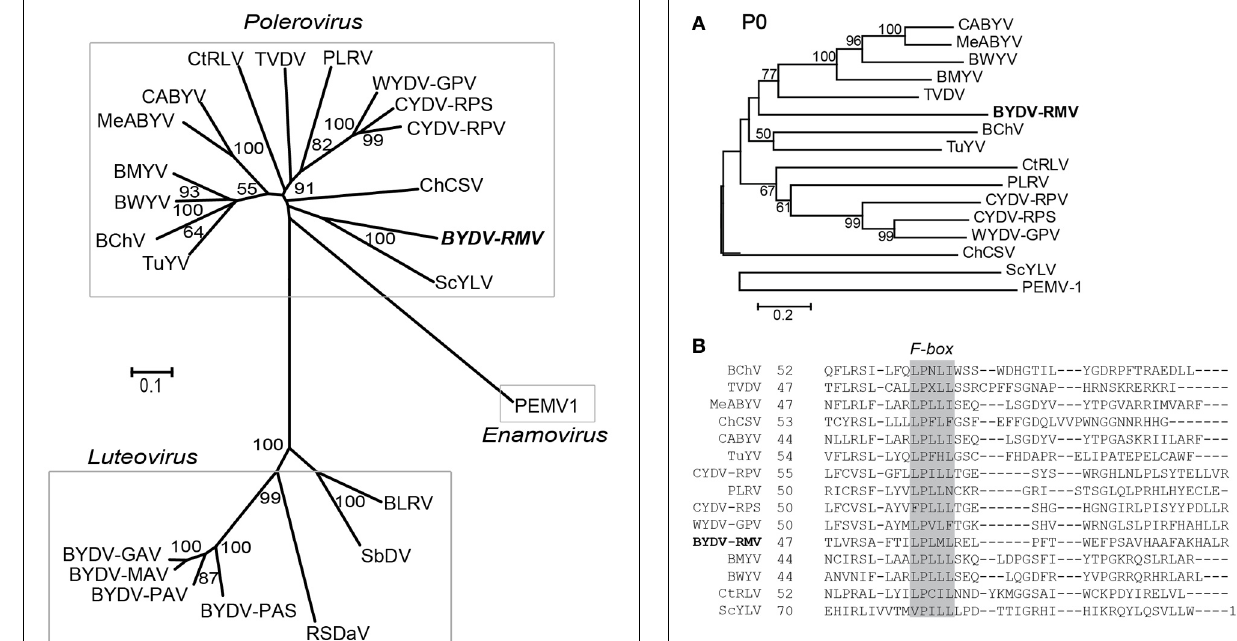
FIGURE 3 | Analysis of P0 amino acid sequences. (A) Amino acid sequences of the P0s for viruses in the Polereovirus and Enamovirus genera were aligned with the MUSCLE algorithm within JalView. The aligned sequences were used for inferring evolutionary relationships using the Neighbor-Joining method. The resultant tree, drawn to scale, is shown with the percentage (greater than 50% only) of 1000 bootstrap replicates. (B) A portion of the MUSCLE aligned P0 showing the conserved F-box domain LPxxL/I among the Polerovirus members. Accession numbers of viral genome sequences used in the alignment are in Table 1